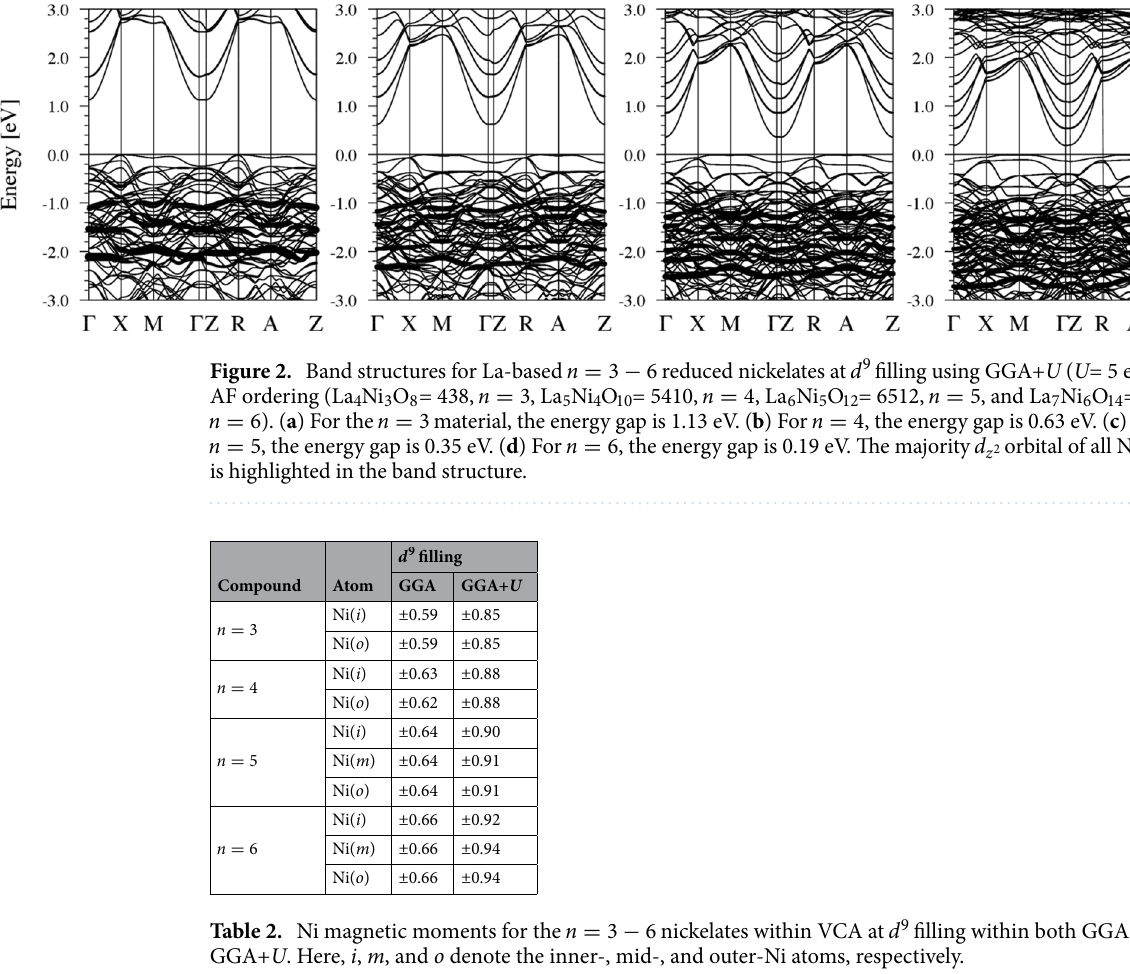
3 , La 5 Ni 4 O 10 = 5410, n 4 , La 6 Ni 5 O 12 = 6512, n = = 3 compound 41 is shown as a reference. =